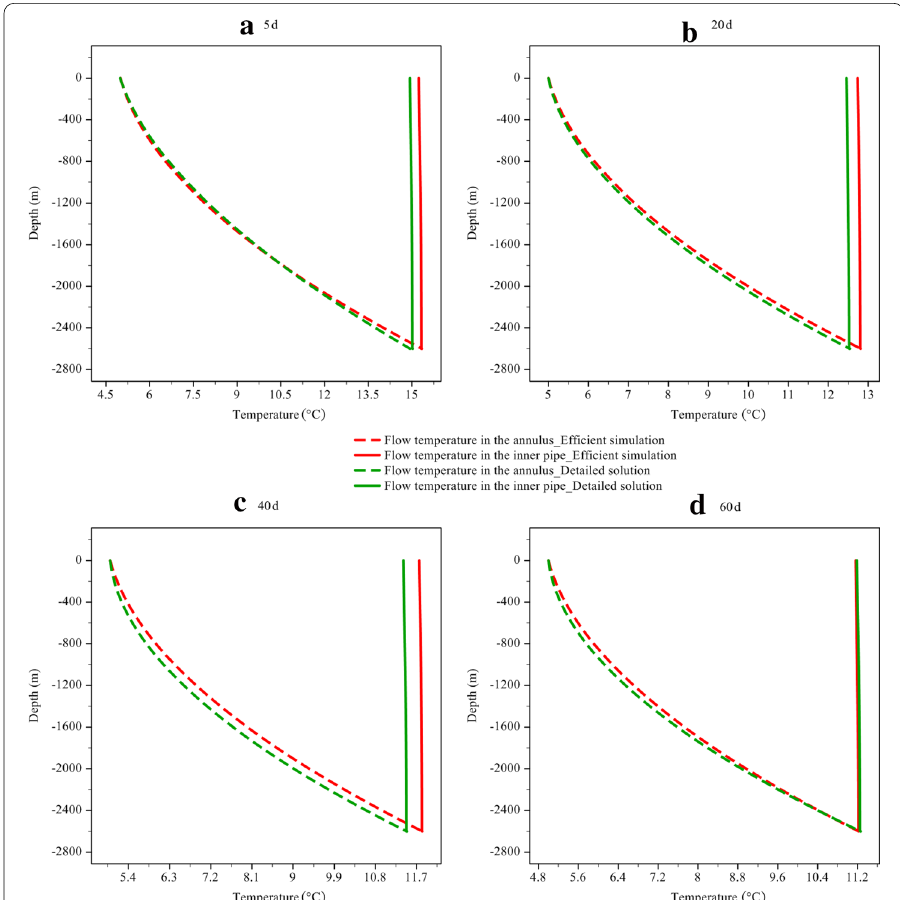
Fig. 12 Comparison of simulation results of circulating flow temperature profiles in the annulus and inside the inner pipe with depth of deep coaxial BHE during the heating season a 5 days, b 20 days, c 40 days,